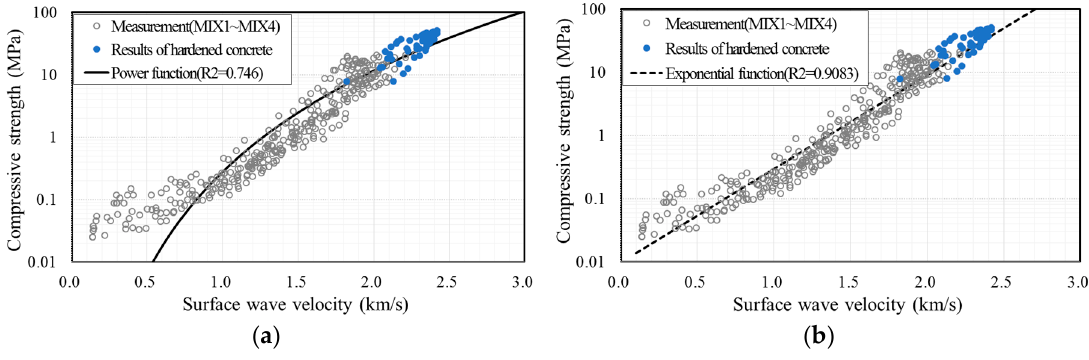
Figure 12. Compressive strength of concrete vs. surface wave velocity on a logarithmic scale for the vertical axis: experimental data fitted by ( a ) the power function of Equation (3) with a = 0.2813 and b = 5.3814 and ( b ) the exponential function of Equation (4) with a = 0.0098 and b = 3.412.